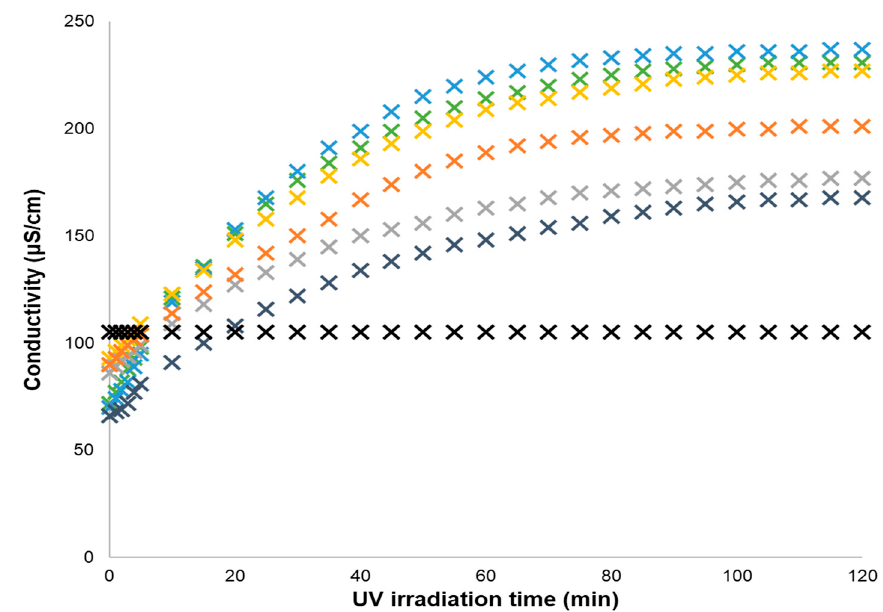
Figure 2. Conductivity data of 6.73 × 10 − 4 mol% GDIL IMCn series and of 1.35 × 10 − 3 mol% KCl aqueous solutions upon UV irradiation time at 25 °C ( X black cross—KCl, X green cross—IMC1, X blue cross—IMC2, X gold cross—IMC4, X gray cross –IMC6, X orange cross—IMC8, X blue-gray cross—IMBENZ).